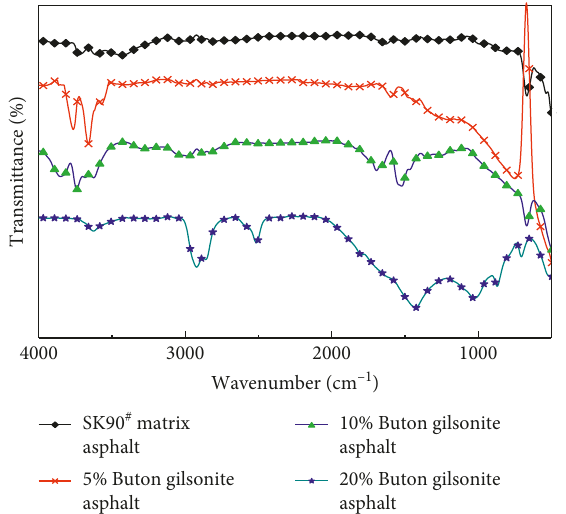
Figure 14: Infrared spectrum analysis of different contents of Buton gilsonite-modified asphalt.